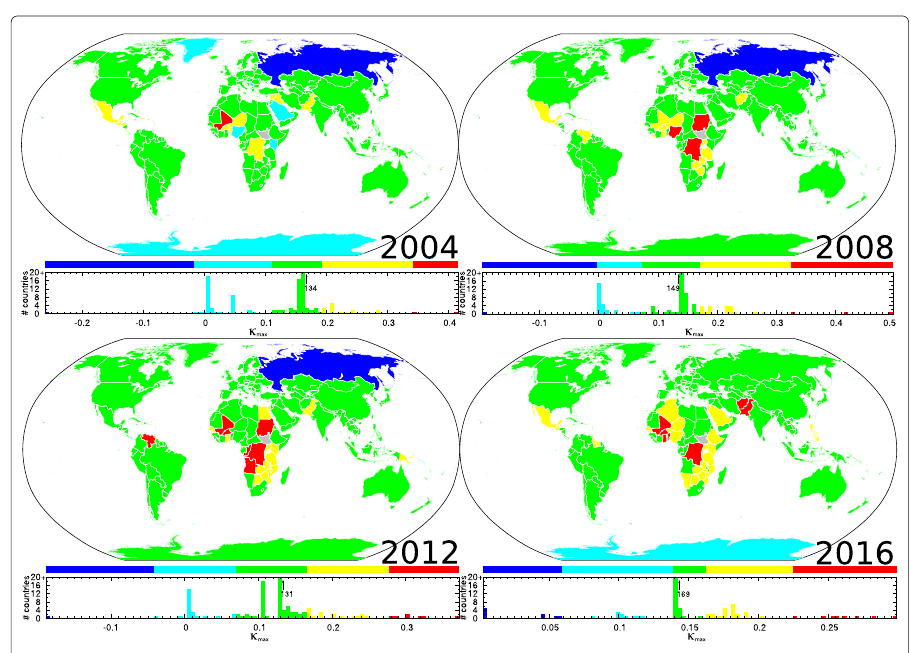
Fig. 6 Geographical distribution of the maximum bankruptcy threshold κ max at which a country goes to bankruptcy at any step of the contagion. Countries with the highest (lowest) κ max are colored in red (blue). Color categories are obtained using the Jenks natural breaks classification method (Wikipedia contributors 2020). Here, once a country goes to bankruptcy, it is prevented to import products with the exception of petroleum and gas (model A). The damping factor is α = 0.5. At this scale, small sized islands are not visible. For information, the blue colored countries for the 2016 WTN are the following islands BV, IO, CC, HM, YT, AN, PN and GS (not visible in the world map)